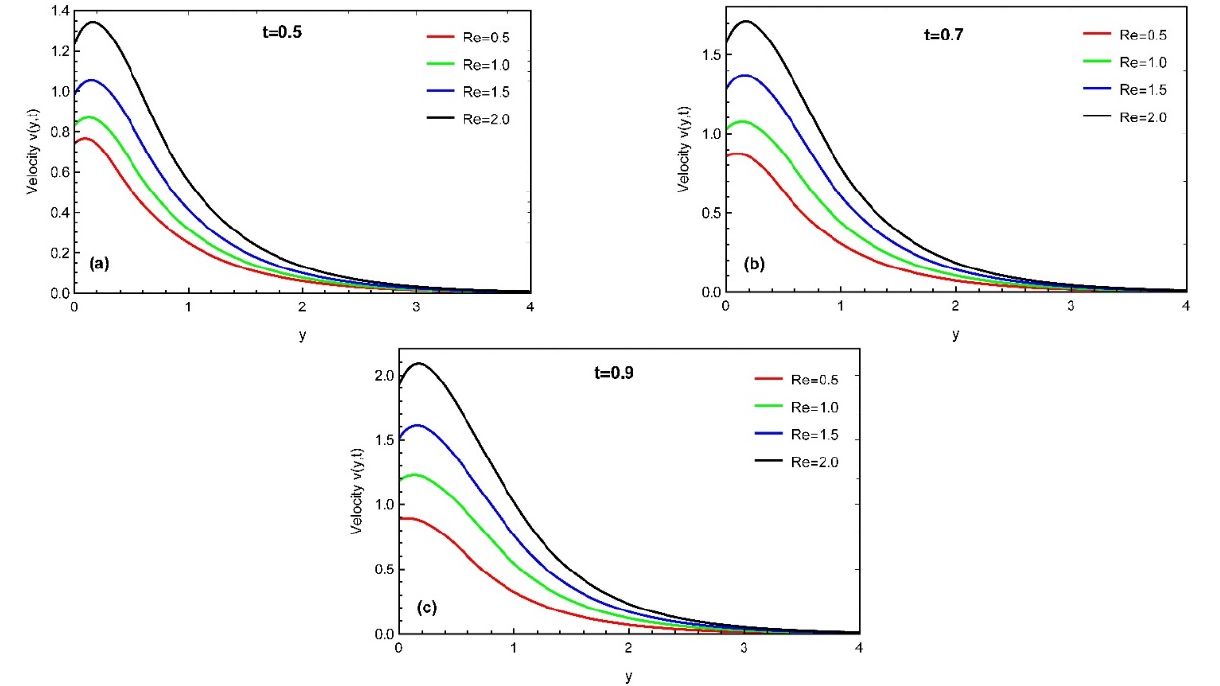
, 𝐾 = 1.4, ℎ = 0.5 at ( a ) 𝑡 = 0.5 ( b ) 𝑡 = 4